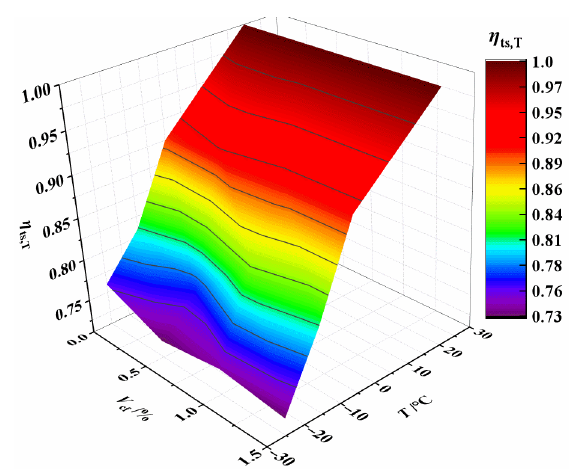
η vs. T and V cf. ts,T